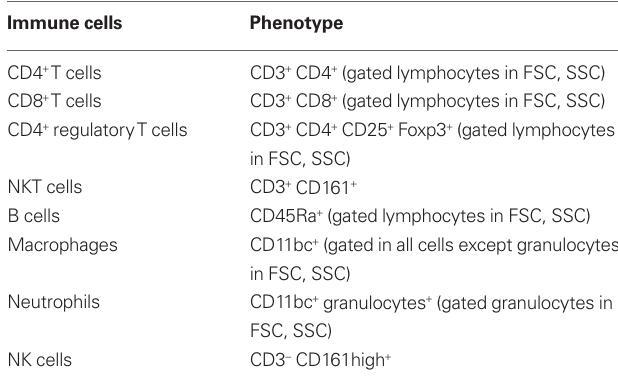
Table 1 | Antibodies used for identification of different spleen